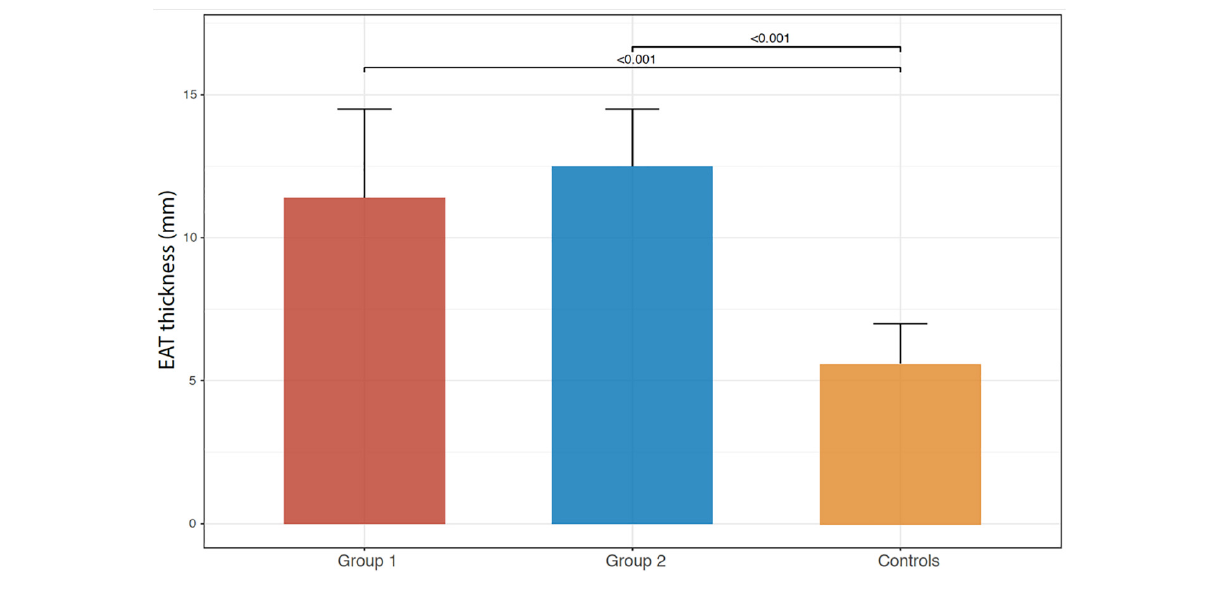
control population, as indicated by the increased serum IL- 1 β concentrations. Interestingly, the different behavior of serum IL-1ra in Groups 1 and 2, begins to delineate differences between